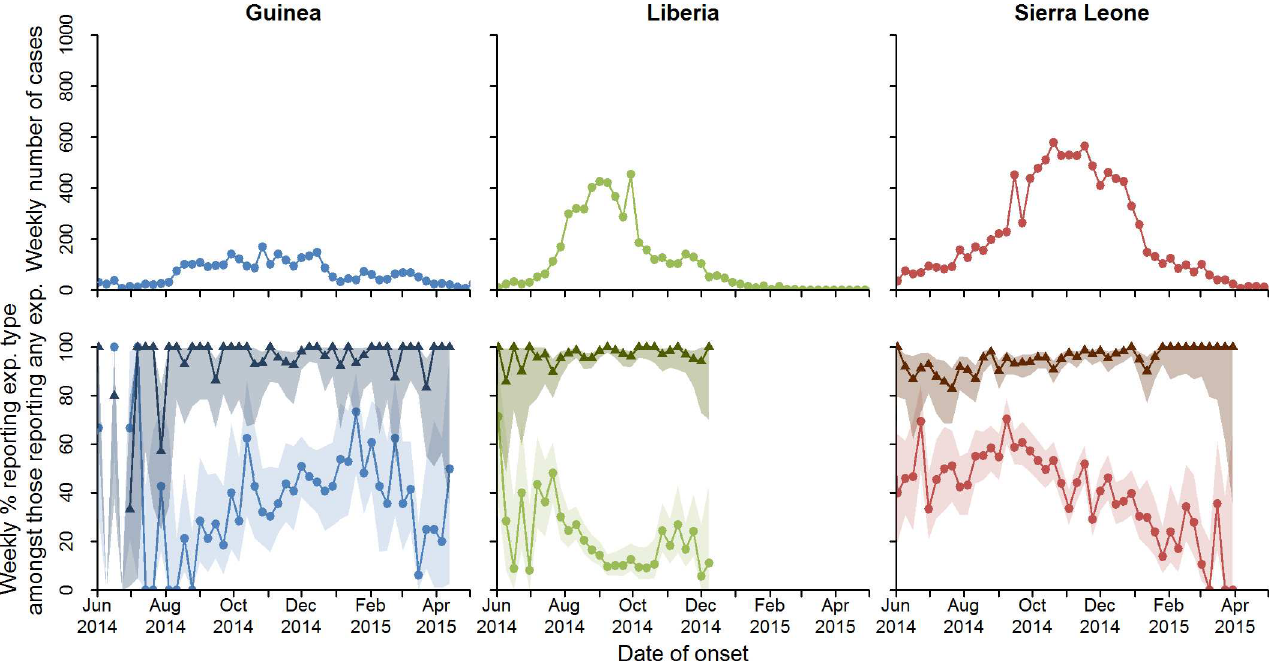
Fig 1. Total number of confirmed and probable cases by week, and percentage who reported funeral and non-funeral exposures. Total number of confirmedand probablecases by week is shown in the top row. Percentage of cases who reported a non-funeral exposure(triangles)or a funeral exposure(circles) is shown in the second row. The shadedregions represent the 95% confidenceintervals aroundthe proportions. Note that cases can report more than one exposure, and so percentages need not add to 100%. exp., exposure.